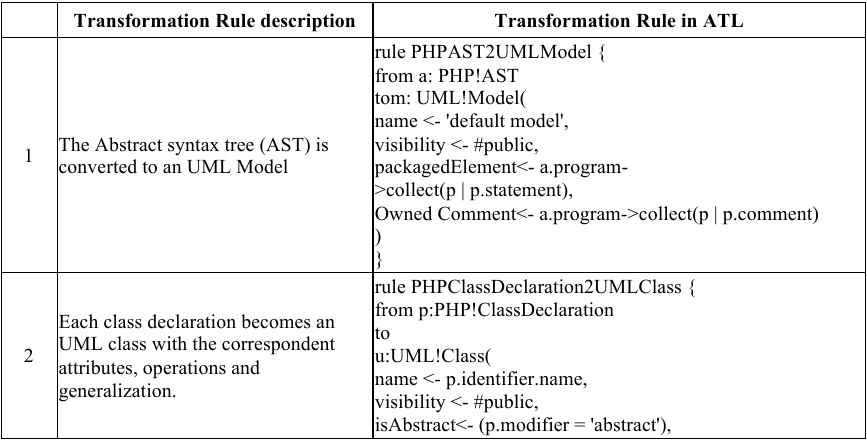
Fig. 5. UML meta model